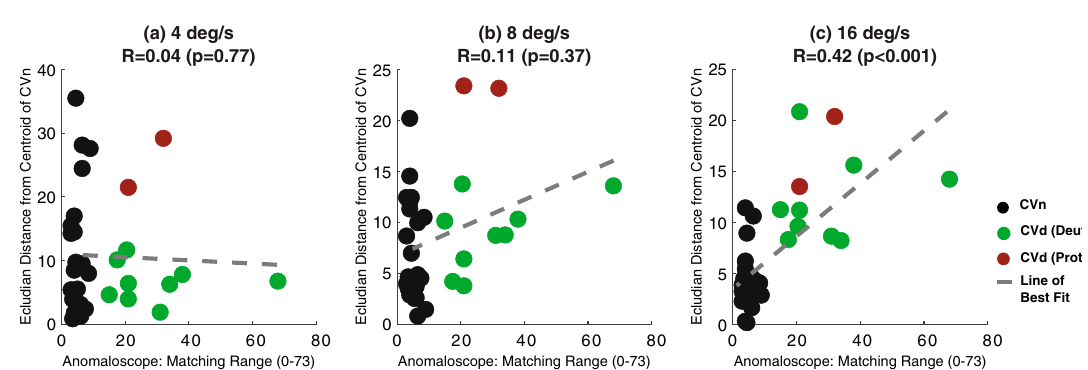
Figure 8. Individual estimates of matching range taken from the anomaloscope test (Appendix A), plot against individual estimates of Euclidean distance from the CVn centroid, for the three speed conditions. Larger matching ranges in the anomaloscope, and larger Euclidean distances are both indicative of more severe CVd. Line of best fit is derived using linear